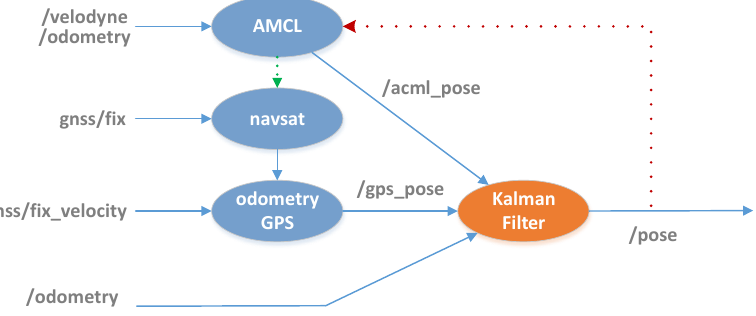
Figure 7. ROS nodes scheme that shows the combination of subsystems that make up the new localization module that will be tested using our framework. This scheme corresponds to the “global navigation satellite system (GNSS)-a Monte Carlo localization (AMCL) fusion” node shown in Figure 8. The “Kalman filter” node uses odometry as a control action, and odometry-GNSS and pose AMCL as observations.